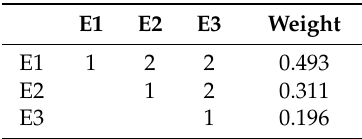
Table A5. Pairwise comparison matrix of Environment